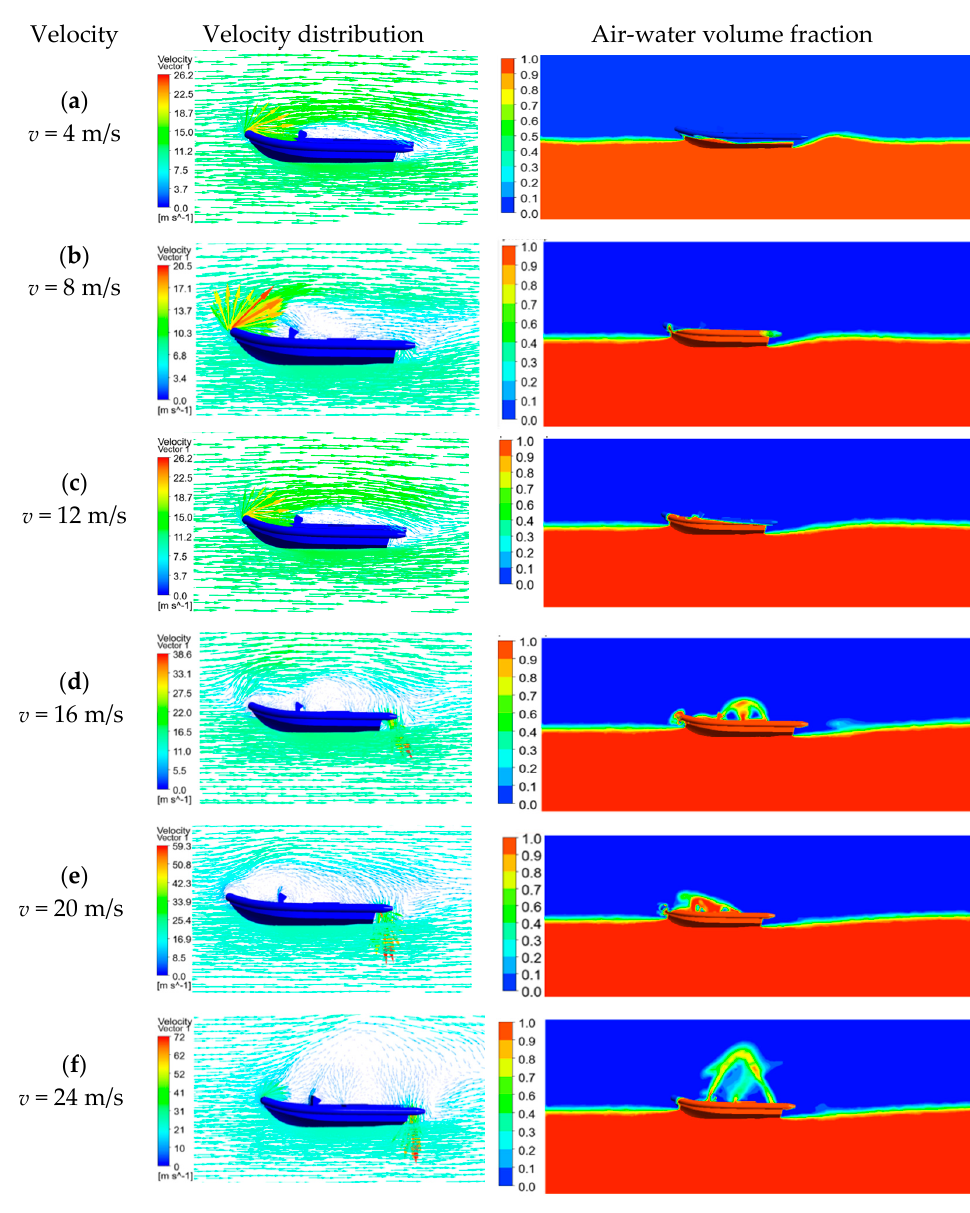
Figure 8. The fluid velocity distribution and air-water volume fraction at different speed.